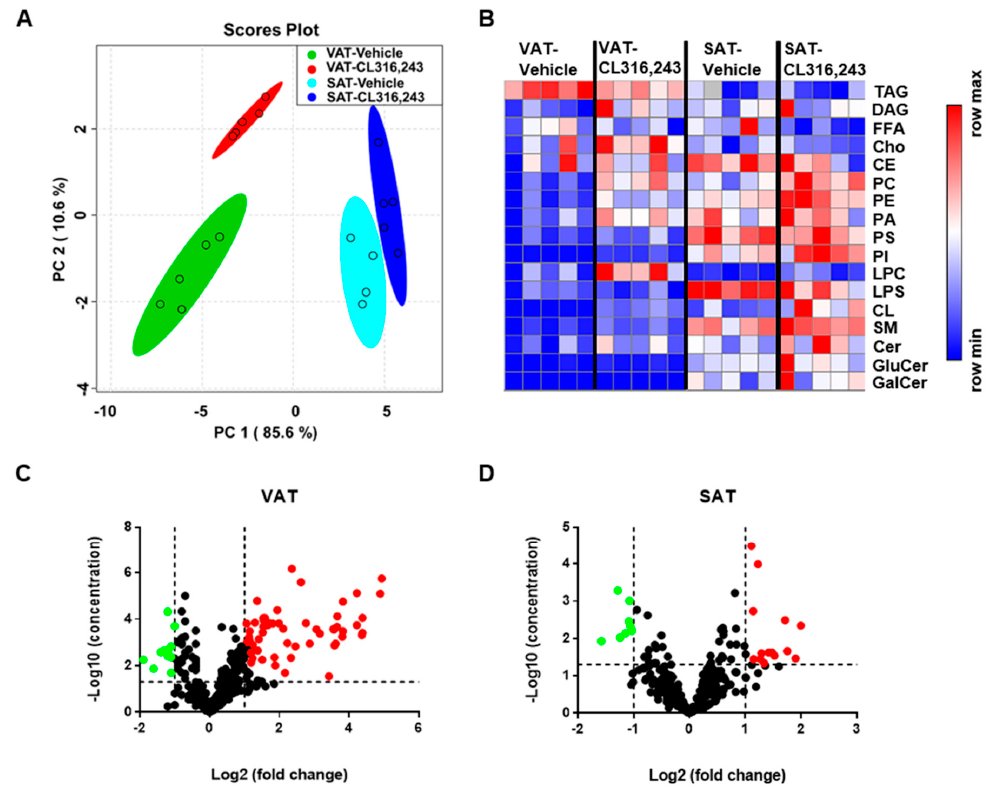
Figure 3. Total composition of lipid classes in VAT and SAT altered in response to CL316,243 treatment. ( A ) Score plot of a multivariate principal component analysis (PCA) of the lipids composition of VAT and SAT from CL316,243-treated C57BL / 6J mice; ( B ) Heatmap visualization of the abundance of 17 lipid classes in VAT and SAT from CL316,243-injected mice. In total, 334 lipid species were quantified, and ( C ) 160 molecular species were significantly changed in VAT, while ( D ) 56 molecular species were dramatically altered in SAT.